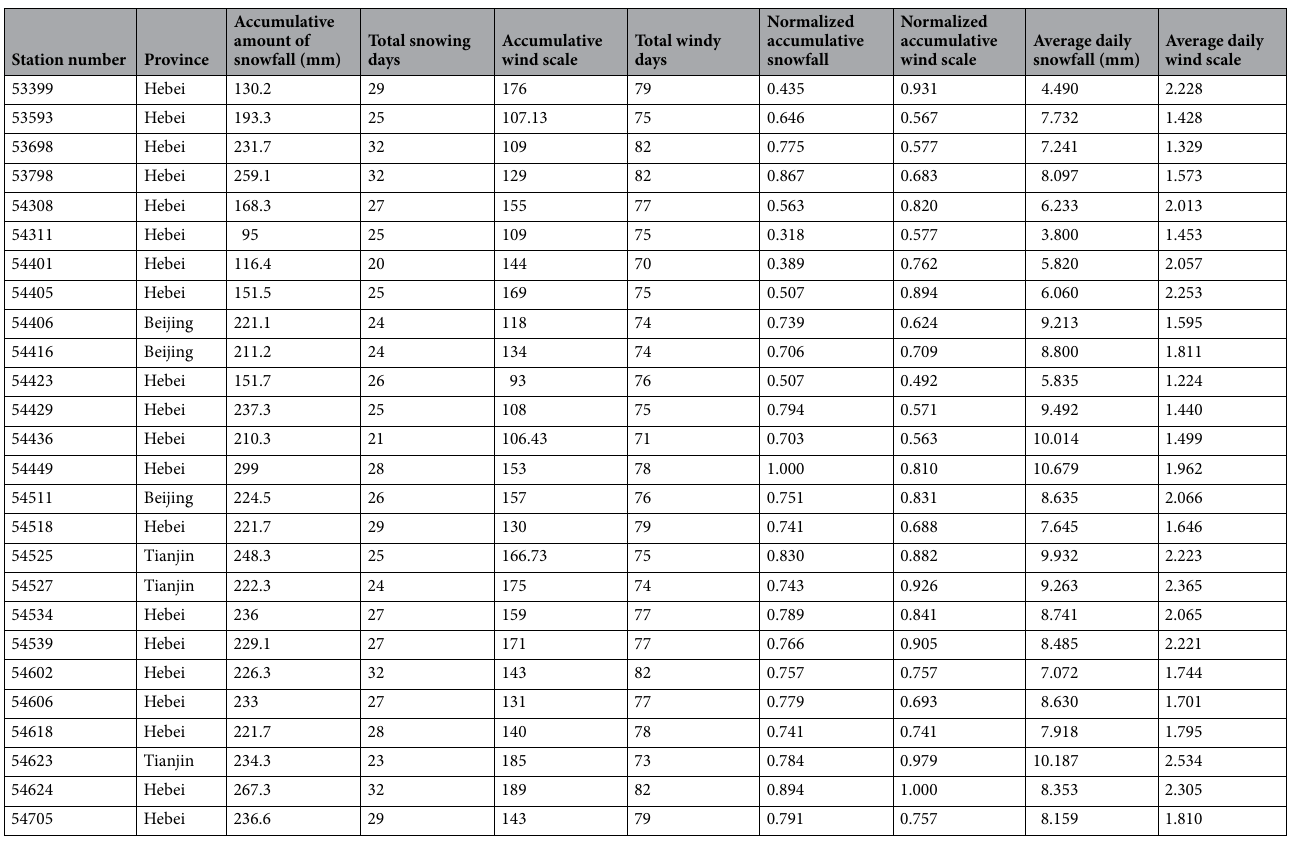
Table 7. Accumulative snowfall and accumulative wind scale taken from the top ten maximum snowfall events at each station in the Beijing–Tianjin–Hebei